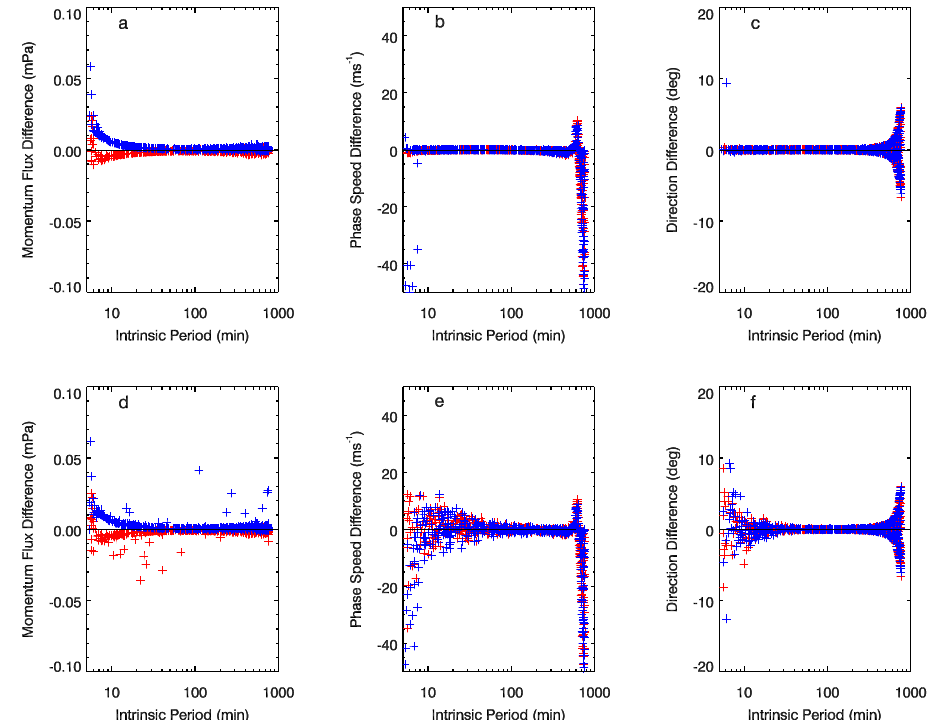
− ρ o u 0 w 0 ) as a function of intrinsic period for (a) with- sim in